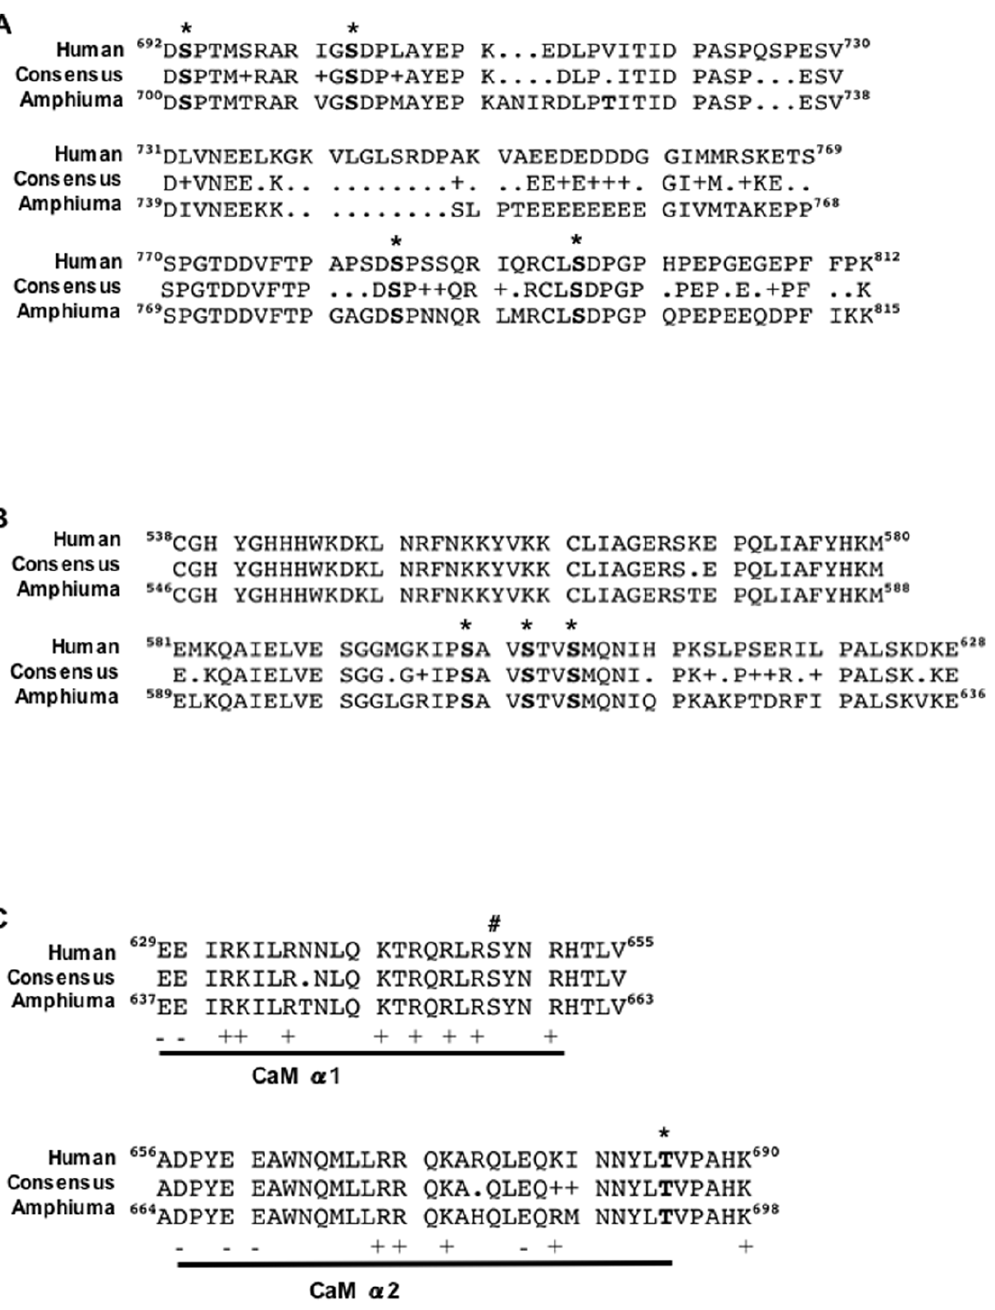
Figure 6. Comparison of C-terminal amino acid consensus sequence and phosphorylation sites in human NHE1 versus Amphiuma NHE1. Human NHE1, Amphiuma NHE1 and consensus sequences are shown for regions of the cytosolic C-terminus that contain phosphorylation sites identified by LC-MS/MS. A. The distal C-terminus. Shown in bold with asterisks are the locations of 4 conserved phosphorylated serine residues within this region: (Amphiuma) S701, S711, S783 and S794. T727, a site unique to Amphiuma NHE1, is also shown in bold. Residues with similarity are noted with + in the consensus sequence. B. The proximal C-terminus. Three conserved phosphorylation sites within this region are shown in bold with asterisks: (Amphiuma) S607, S610 and S613. C. Comparison of sequence information and phosphorylation sites of the volume-sensitive calmodulin (CaM) binding region in human versus Amphiuma NHE1. The helical domains necessary for CaM binding shown ( a 1 and a 2) are based on structural studies by Ko¨ster et al [42], indicating CaM binding domains that are necessary for cell shrinkage-induced transport activity [41]. This region is 97% identical between human and Amphiuma NHE1. Shown in bold with an asterisk is the location of (Amphiuma) threonine 693, a conserved phosphorylation site within this region. The location of human S648 is also noted ( # ). Positive and negatively charged residues within the CaM binding regions are denoted below with + or 2 .